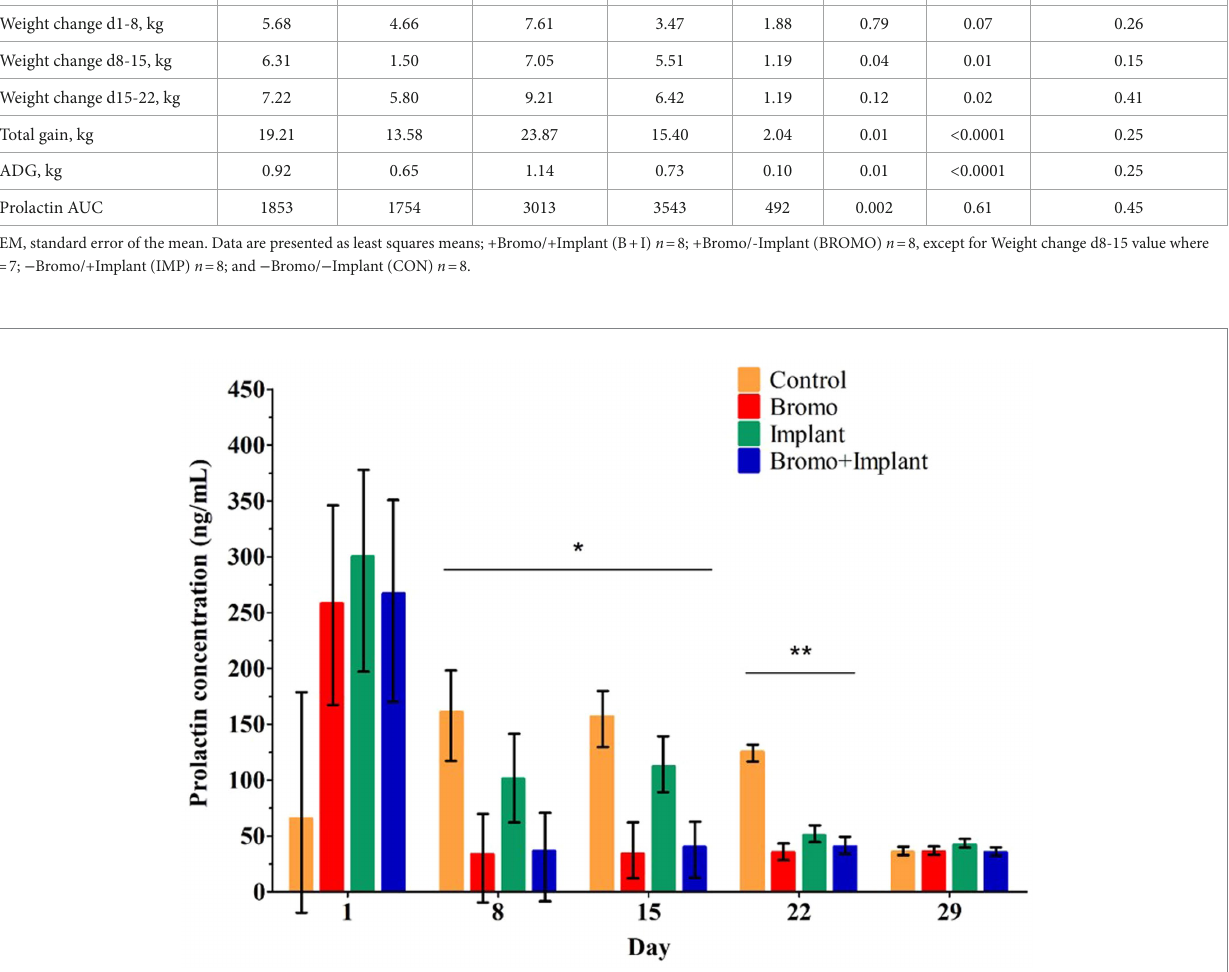
TABLE 2 DM intake, initial BW, ADG, and prolactin area under the curve in steers treated with bromocriptine and estradiol/TBA implants. + Bromo − Bromo p -values + − Implant + Implant − Implant SEM 1 Bromo Implant Bromo * Implant Implant